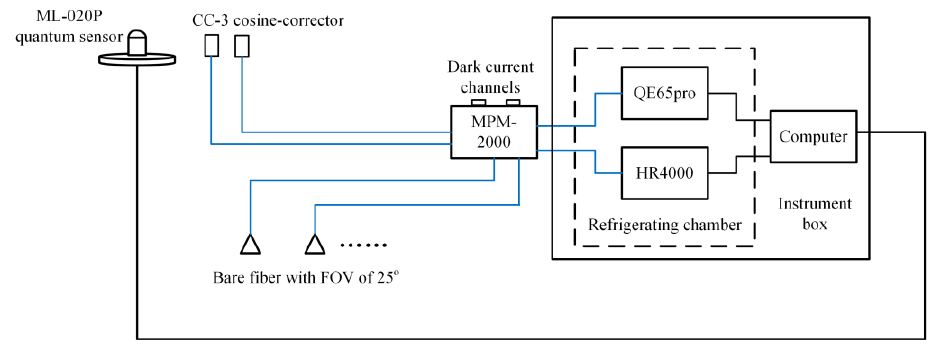
Figure 1. Schematic illustration of the improved AutoSIF structure. The solid blue lines represent the fibers. The black connecting lines represent the data transmission lines. fibers. The black connecting lines represent the data transmission